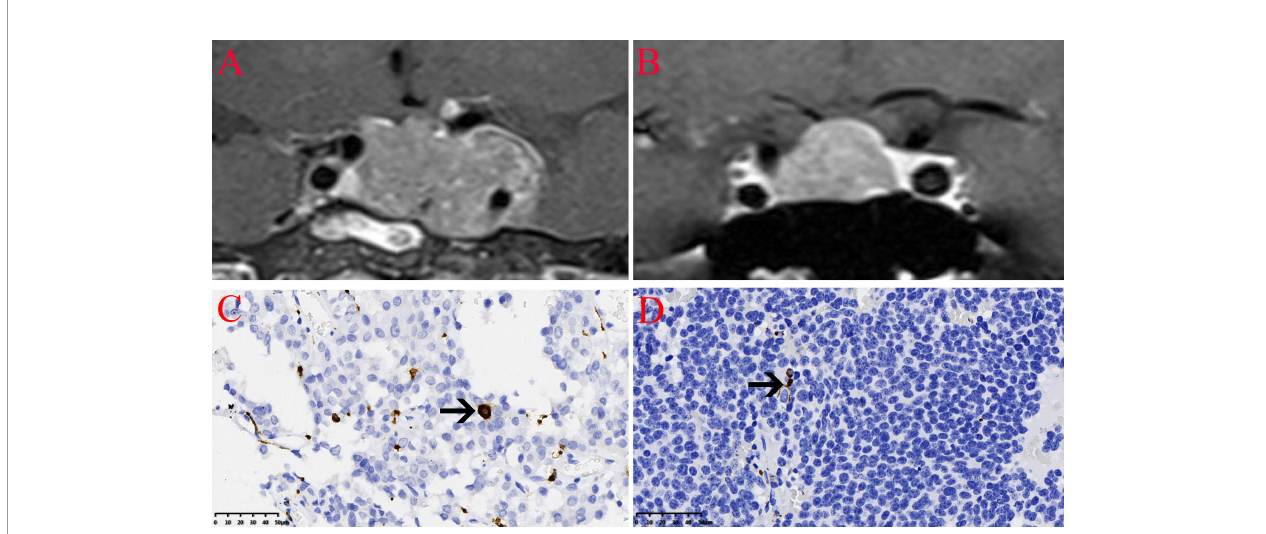
FIGURE 5 | In fi ltration of CD206 macrophages in nonfunctioning pituitary adenomas NFPAs. The CD206 macrophages are indicated by the arrow. (A) Coronal contrast-enhanced image showing invasive pituitary adenomas. (B) Coronal contrast-enhanced image showing non-invasive pituitary adenomas. (C) In fi ltration of CD206 macrophages in invasive NFPAs. (D) In fi ltration of CD206 macrophages in non-invasive